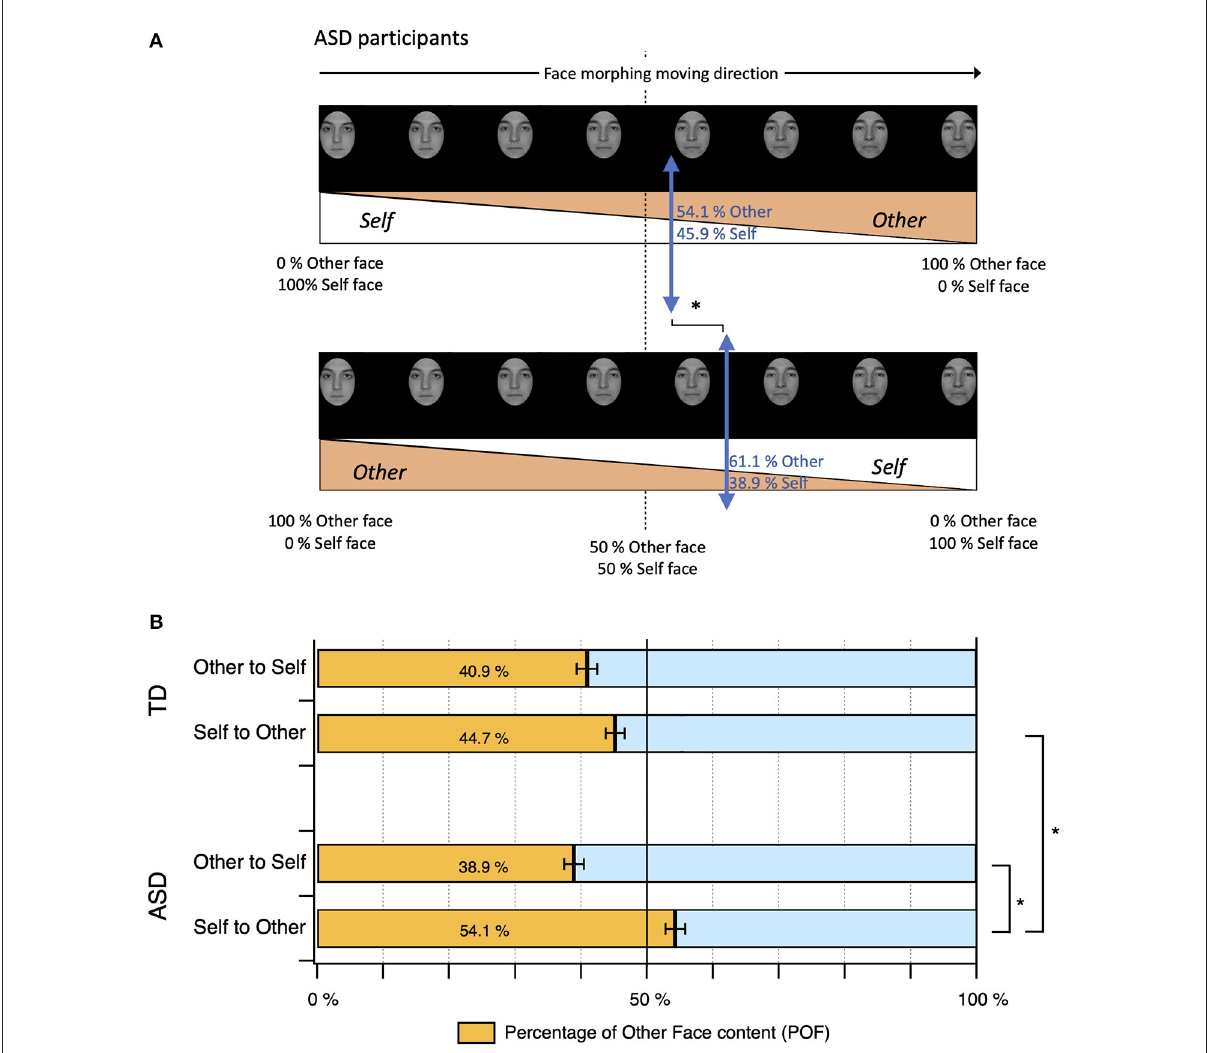
FIGURE2 Discrimination of Self vs. Other face. (A) ASD participant responses during the task. (B) The bar graph presents the mean Percentage of Other Face (POF) content (orange bars) that participants perceived during the various conditions presented here.